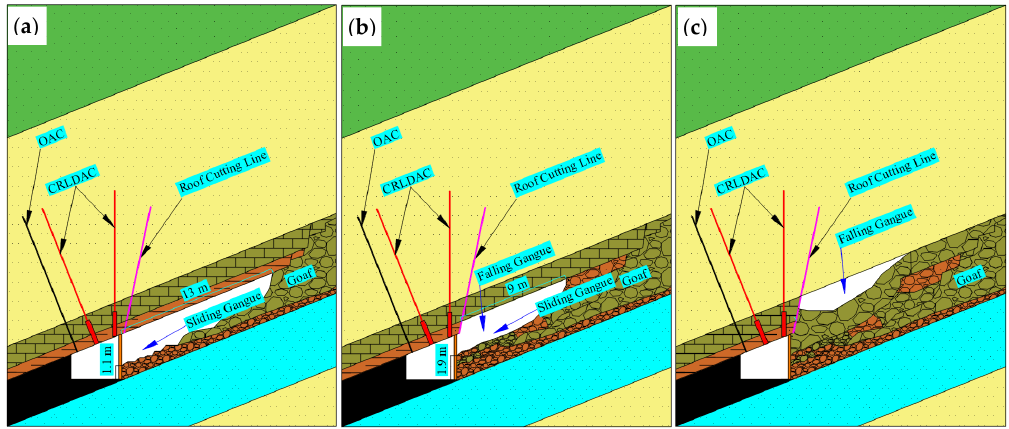
Figure 22. Filling process of gangue rib: ( a ) sliding filling stage; ( b ) sliding filling and falling filling stage; ( c ) falling filling stage.